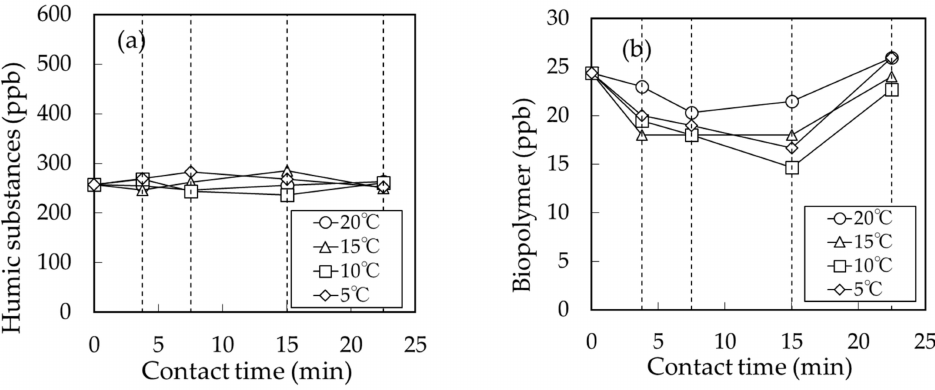
Figure 4. Effect of contact time and operating temperature on the removal of ( a ) humic substances and ( b ) biopolymer by the BCF.